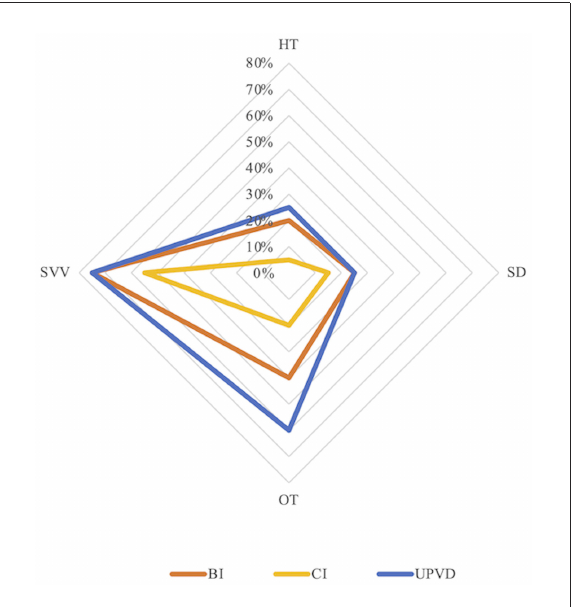
FIGURE1 Prevalence of skew deviation (SD), ocular torsion (OT), head tilt (HT), and subjective visual vertical (SVV) tilt in the three groups. BI, brainstem infarction; CI, cerebellum infarction; UPVD, unilateral peripheral vestibular disorders.